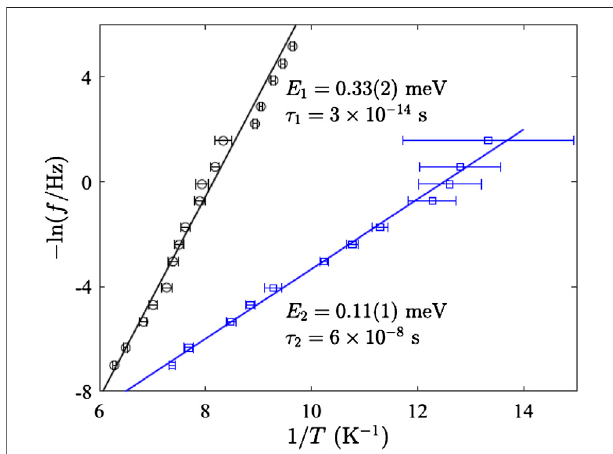
FIGURE 14 | Arrhenius plot for the two peaks in χ ′′ for the single crystal of GGG. The straight lines are fi ts to the Arrhenius